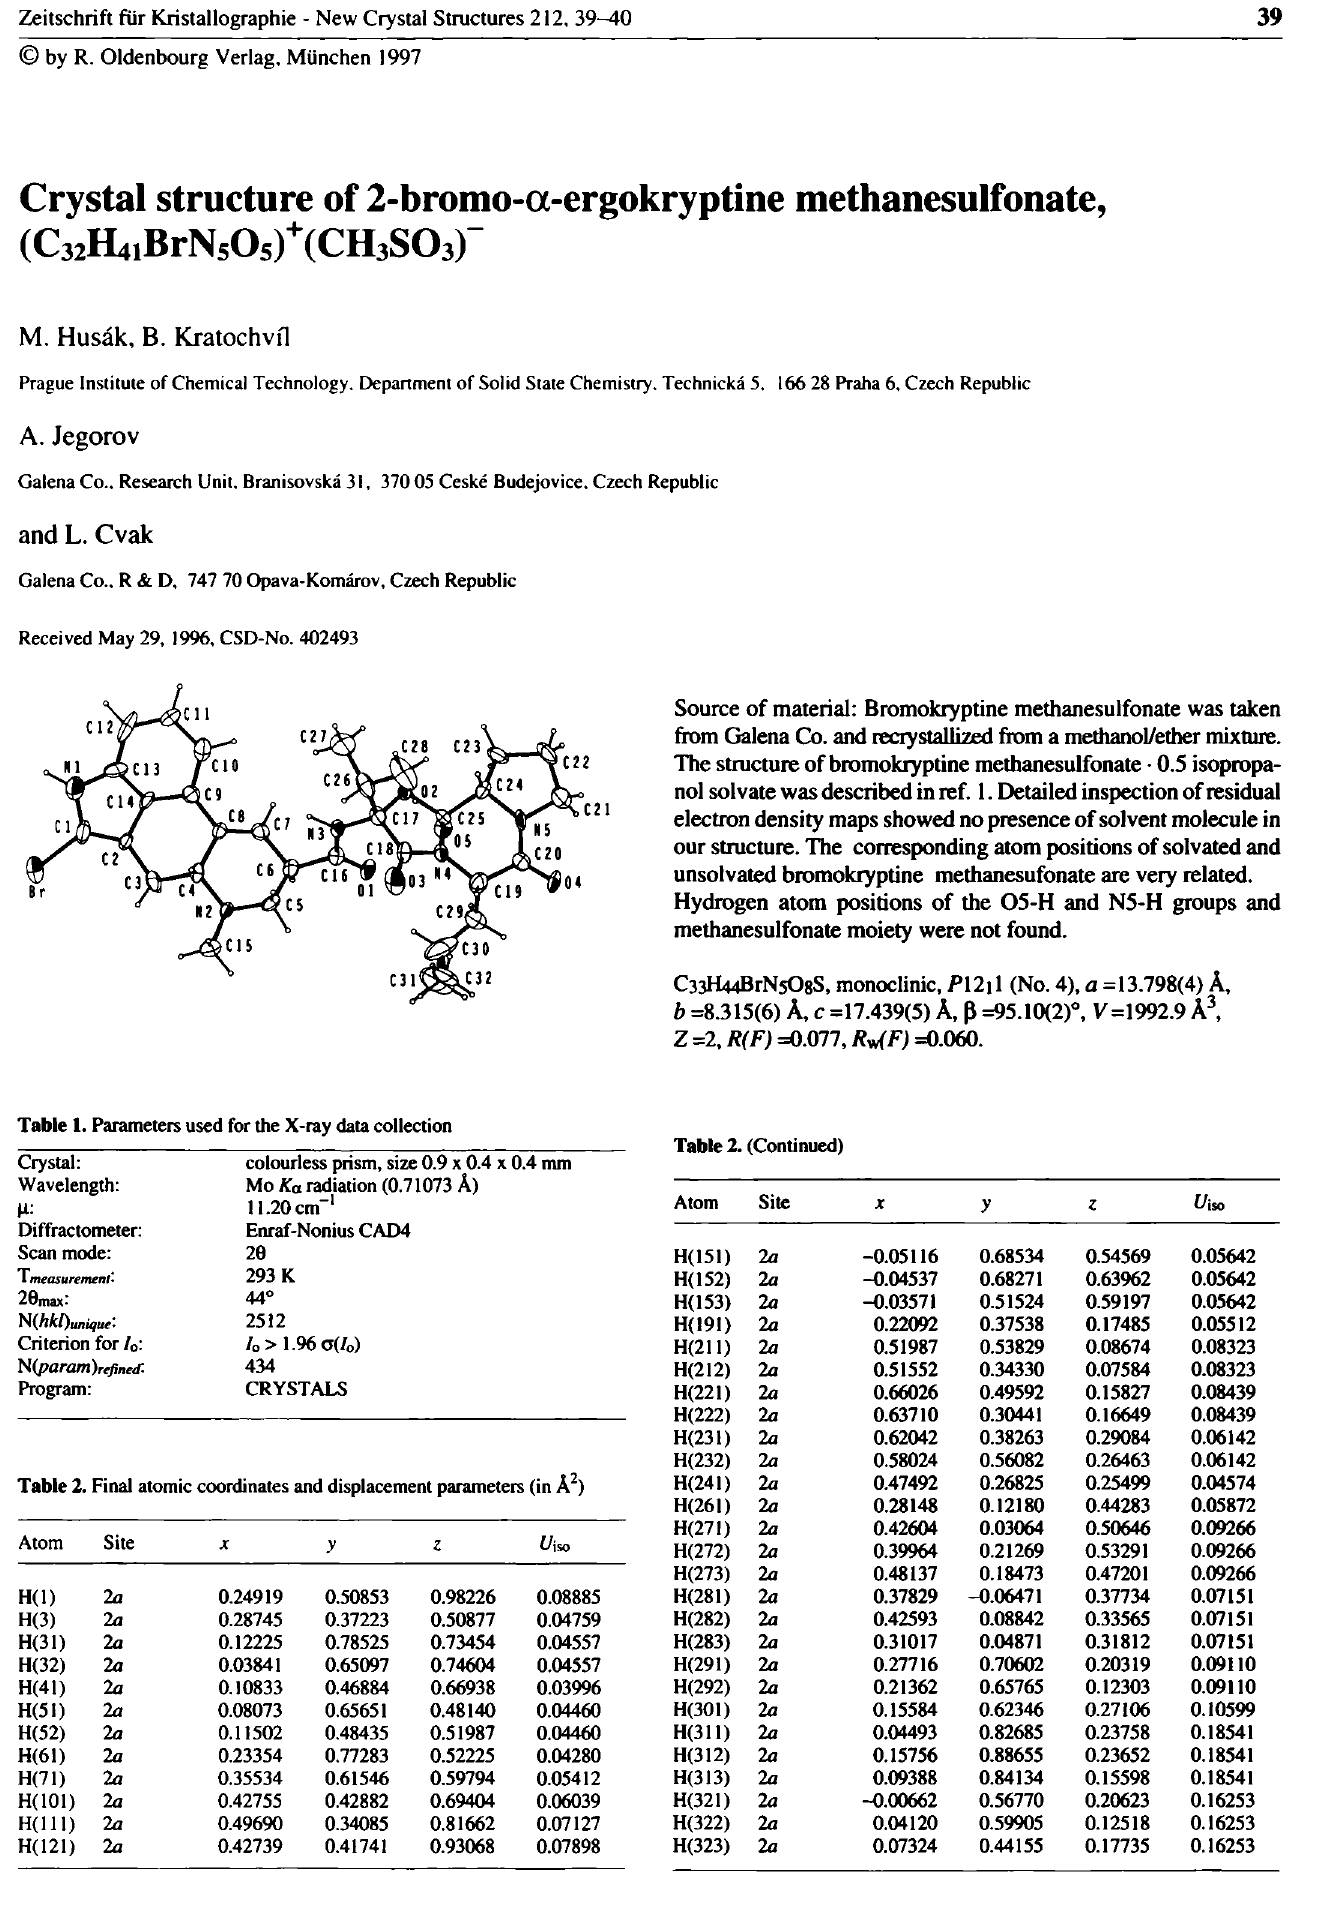
Table 1. Parameters used for the X-ray data collection Crystal: